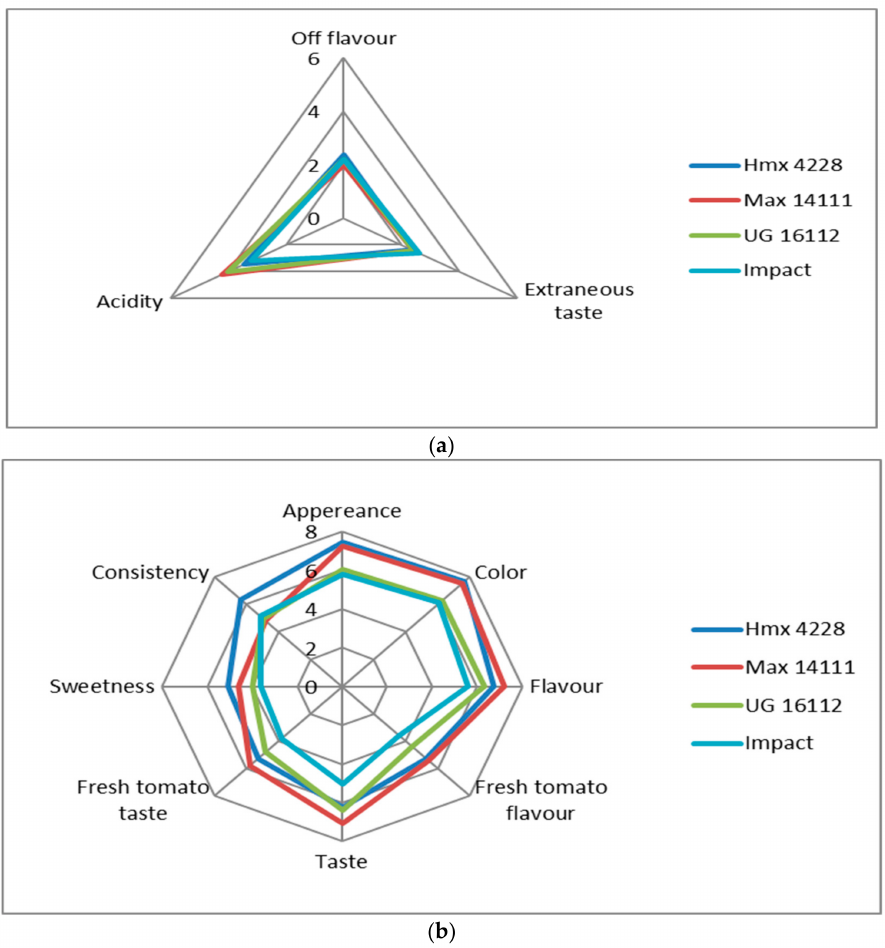
Figure 3. Organoleptic evaluations of diced tomato fruits: ( a ) Sensorial profiles of the undesired features, named negative. ( b ) Sensorial profiles of the desired features, named